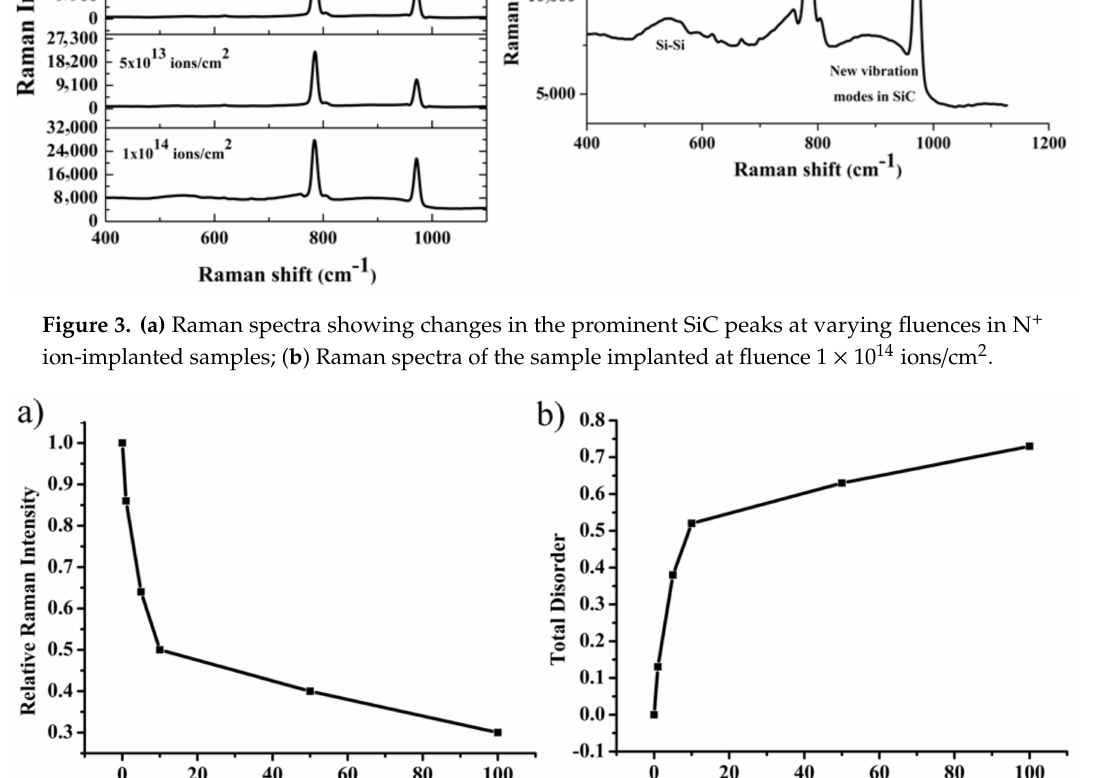
Figure 4. Variation in ( a ) relative Raman intensity, ( b ) total disorder following 10 keV N +